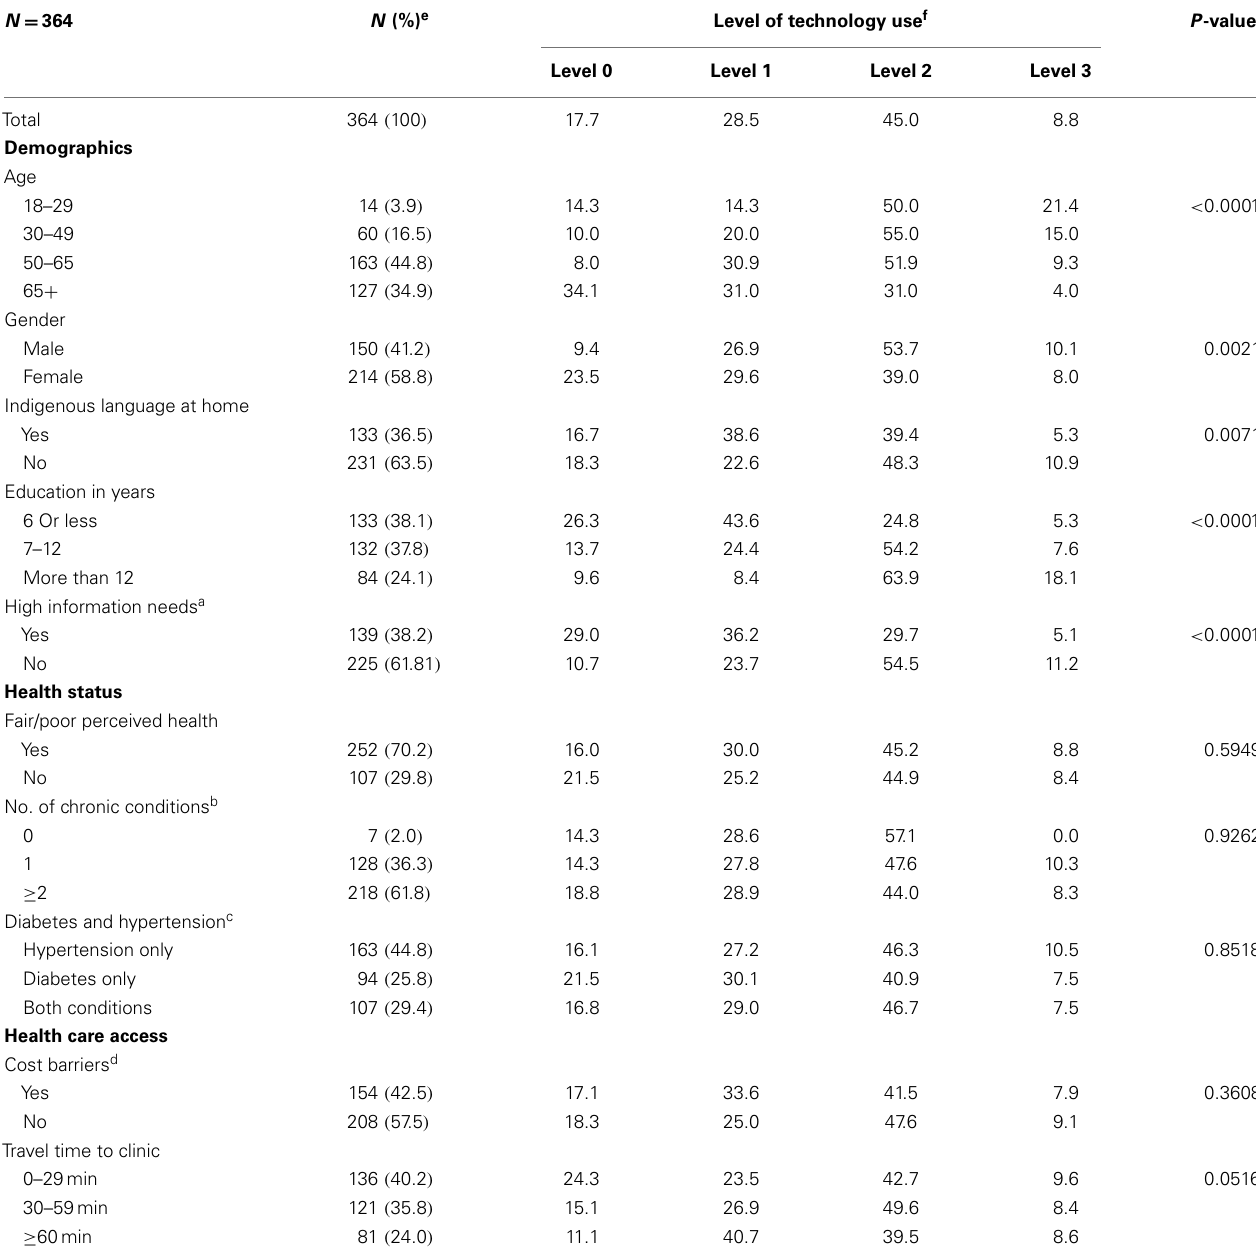
Table 1 | Characteristics of primary care patients with diabetes and/or hypertension in La Paz, Bolivia by level of engagement with mobile technology